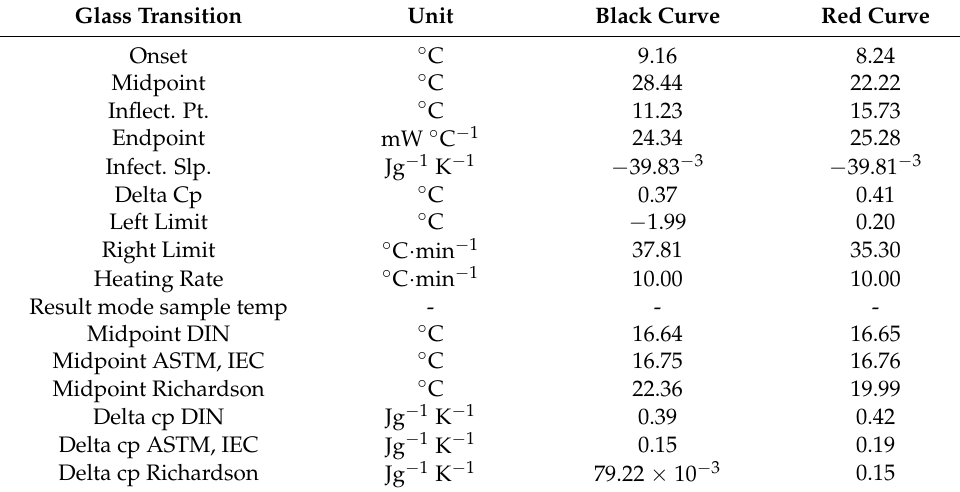
Table 2. Figure 11 curves output